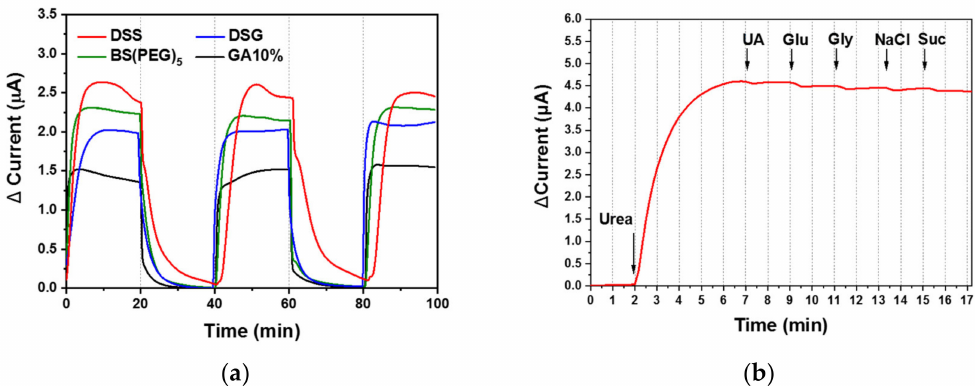
Figure 7. ( a ) The DSS urea biosensor was subjected to ( a ) repeatability testing (in triplicate) of urea biosensor performance, in which 10 mM urea-spiked PBS solution flowed into the biosensor for 20 min, followed by pure PBS for 20 min; and ( b ) interference testing with various interfering species (2 µ M uric acid (UA), 30 µ M glucose (Glu), 2 µ M glycine (Gly), 3 mM sodium chloride (NaCl) and 50 µ M sucrose (Suc)), in which 10 mM urea PBS solution flowed into the biosensor, followed by 10 mM urea PBS solution with the interfering